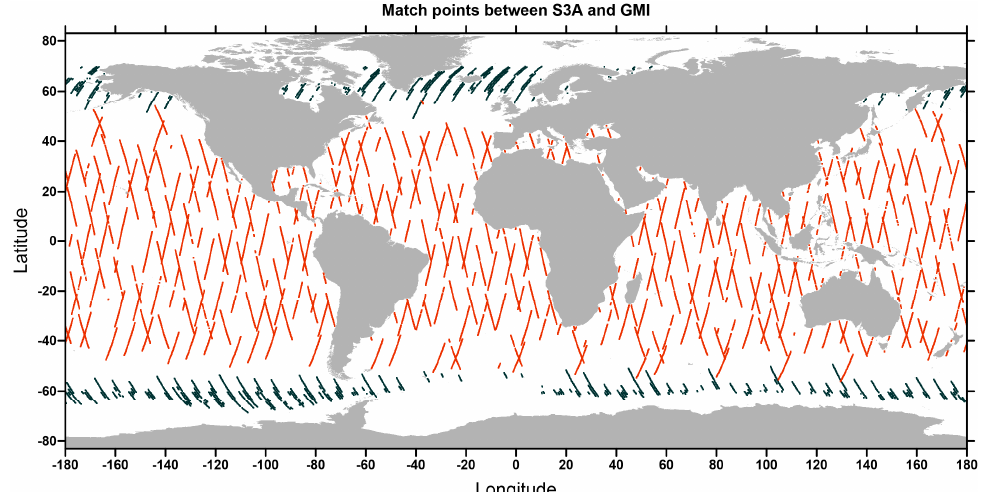
Figure 7. Match points between the GMI and S3A. Colours correspond to different time periods, indicated in Figure 5 by the corresponding colour bars.